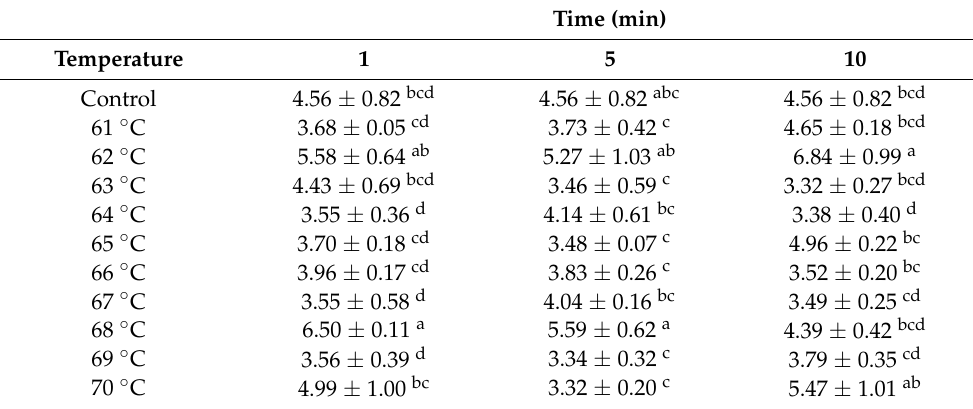
Table 3. Average particle size ( µ m) of mayonnaise prepared with thermally treated (61~70 ◦ C, 1, 5, and 10 min)